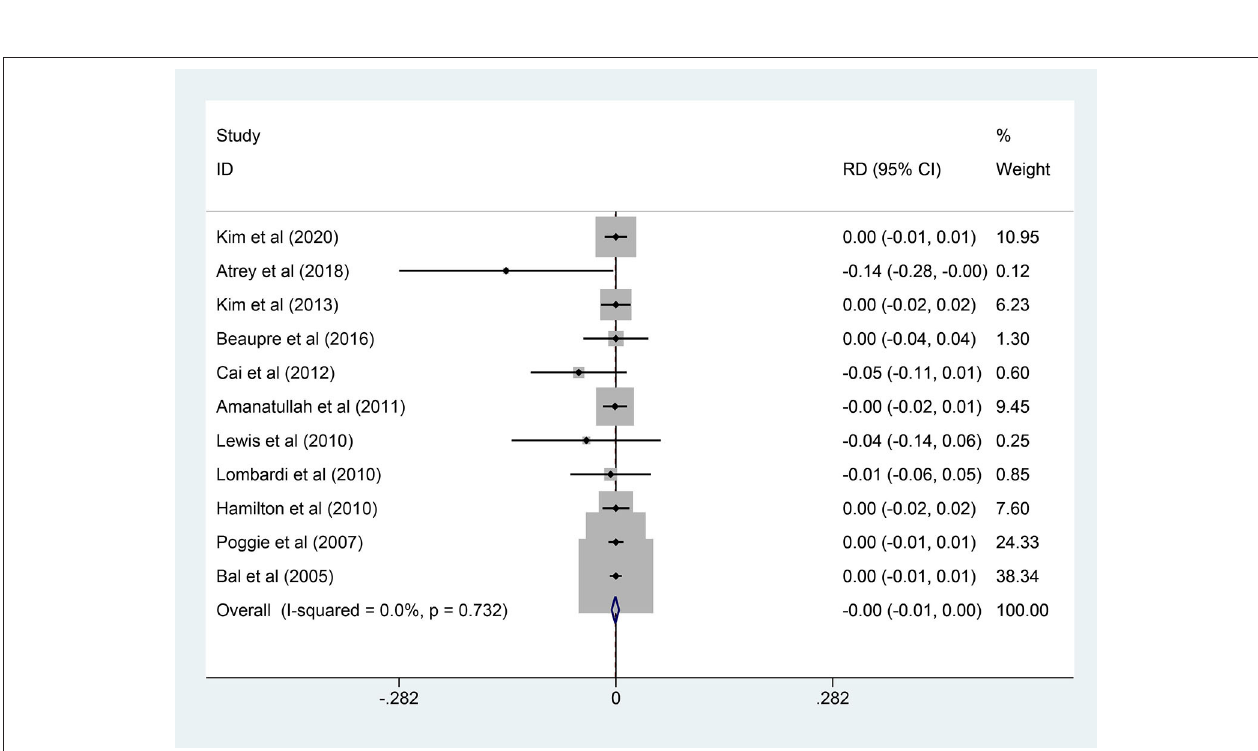
FIGURE 7 | Forest plot diagram of the overall osteolysis rate of the replaced hip with COC and COP bearing surfaces.